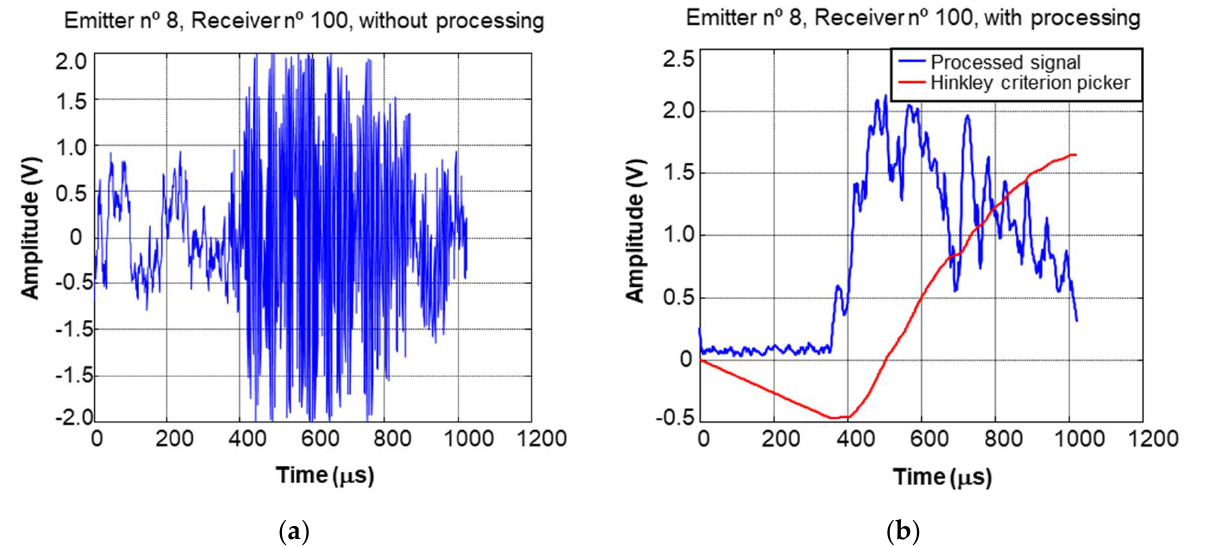
Figure 15. Received A-scan from the cross section of the shaft: ( a ) before and ( b ) after applying a filter.